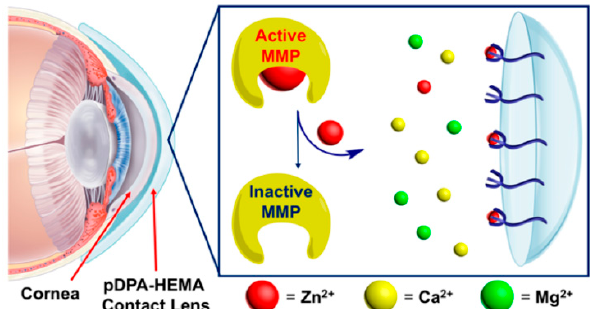
Figure 8. Schema of deactivation of matrix metalloproteinases (MMPs) by the dipicolylamine–poly(2-hydroxyetyl methacrylate (pDPA–HEMA)-based contact lens. Reproduced from [89], with permission from ACS Publications, 2019.